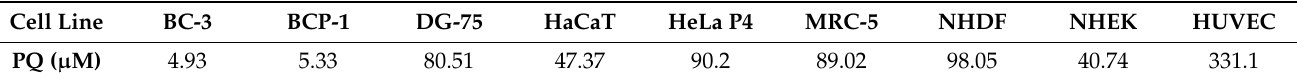
Table 1. The CC50 values of PQ in HHV-8-infected and HHV-8-uninfected cells. CC50, cytotoxic concentration that reduces cell viability by 50% after 48 h of PQ treatment. The CC50 values were calculated using GraphPad Prism